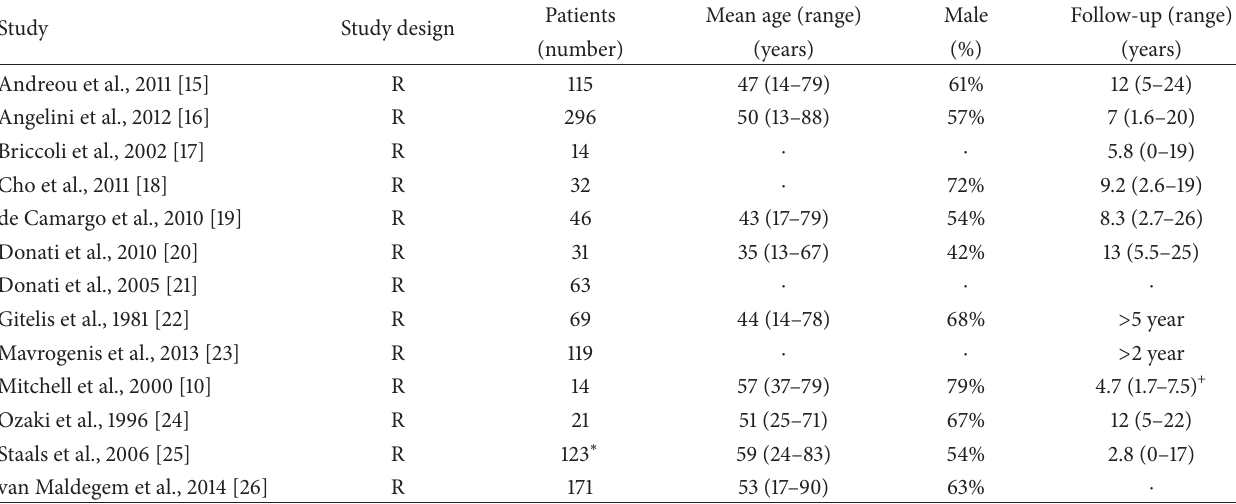
Table 1: Demographic patient and study characteristics of the included